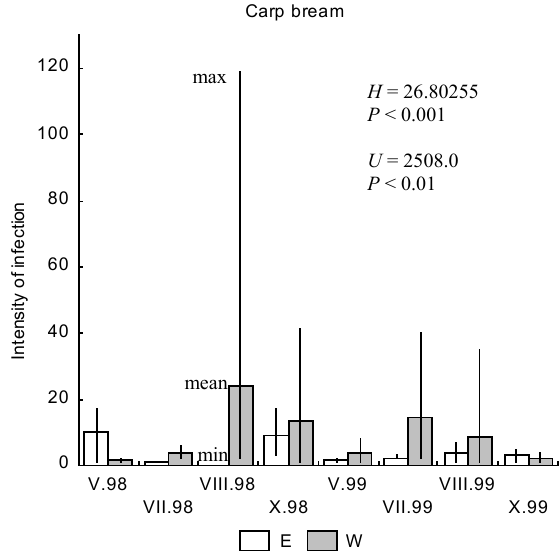
Fig. 6. Intensity of infection of carp bream with P. cuticola in samples from eastern- (E) and western (W) part of OÊwin Lake; H , Kruskal–Wallis statistics for seasonal differences; U , Mann–Whitney statistic for location differences